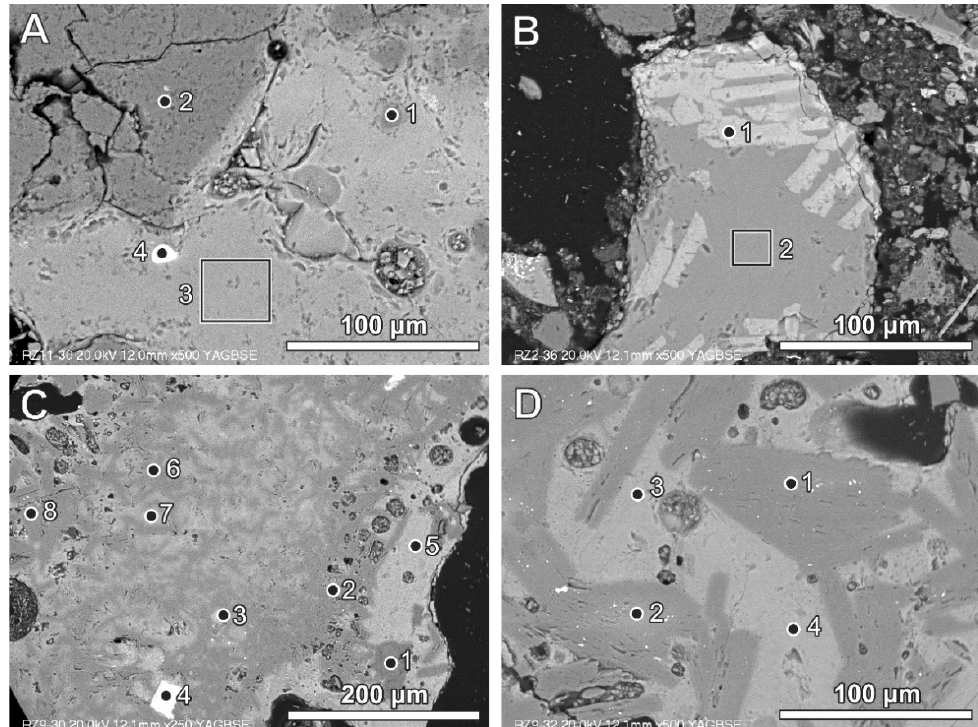
Figure 2. ( A ) Glassy fragment in BA (bright grey) with quartz grains (dark grey) and zircon grain (white)—numbers of spots and area correspond to the analyses presented in Table 3 (SEM BSE image, sample RZ11); ( B ) glass containing wollastonite crystals (bright lathes)—numbers of spots and area correspond to the analyses presented in Table 3 (SEM BSE image, sample RZ2); ( C ) small Al-rich plates (dark grey) dispersed in glass (brighter grey)—numbers of spots and area correspond to the analyses presented in Table 3 (SEM BSE image, sample RZ9); ( D ) Al-rich plates dispersed in the Al-, Si-, and Ca-rich phase—numbers of spots and area correspond to the analyses presented in Table 3 (SEM BSE image, sample RZ9).